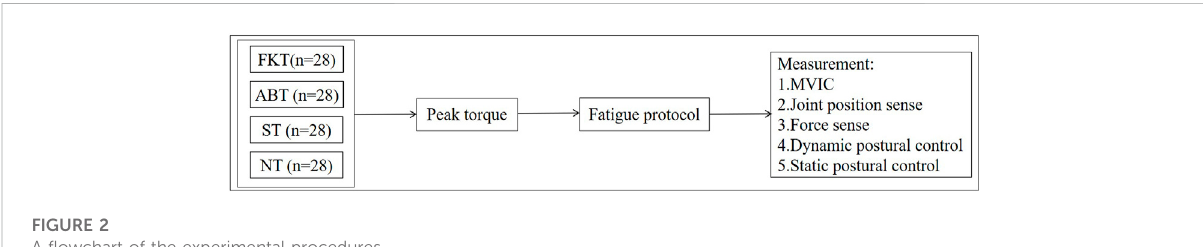
FIGURE 2 A fl owchart of the experimental procedures.